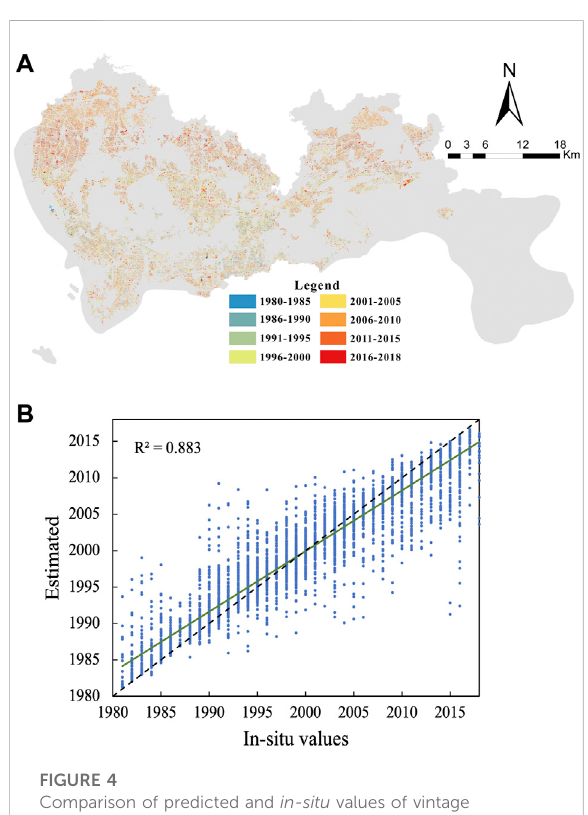
FIGURE 4 Comparison of predicted and in-situ values of vintage estimation. (A) shows the spatial pattern of building vintage in Shenzhen. (B) shows estimated and in-situ values of building